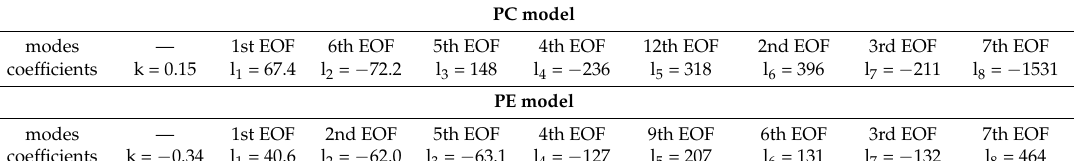
Table 6. Selected EOF modes and regression coefficients (4) of phycocyanin (PC) and phycoerythrin (PE) models.